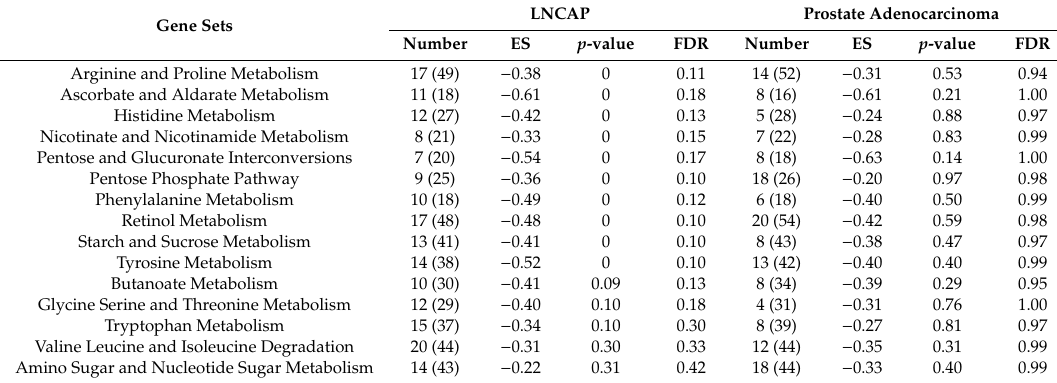
Table 2. Upregulated gene sets involved in the metabolism of polar metabolites in the LNCAP cell line and prostate adenocarcinoma